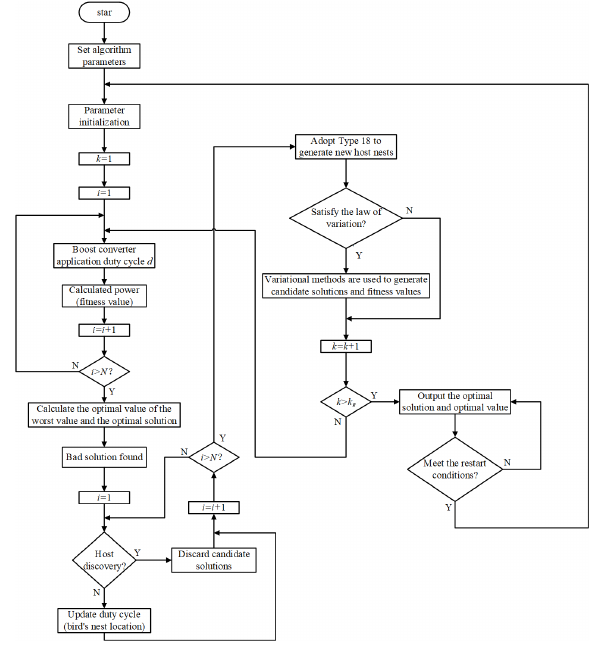
Fig. 4. CSAGAM flow block